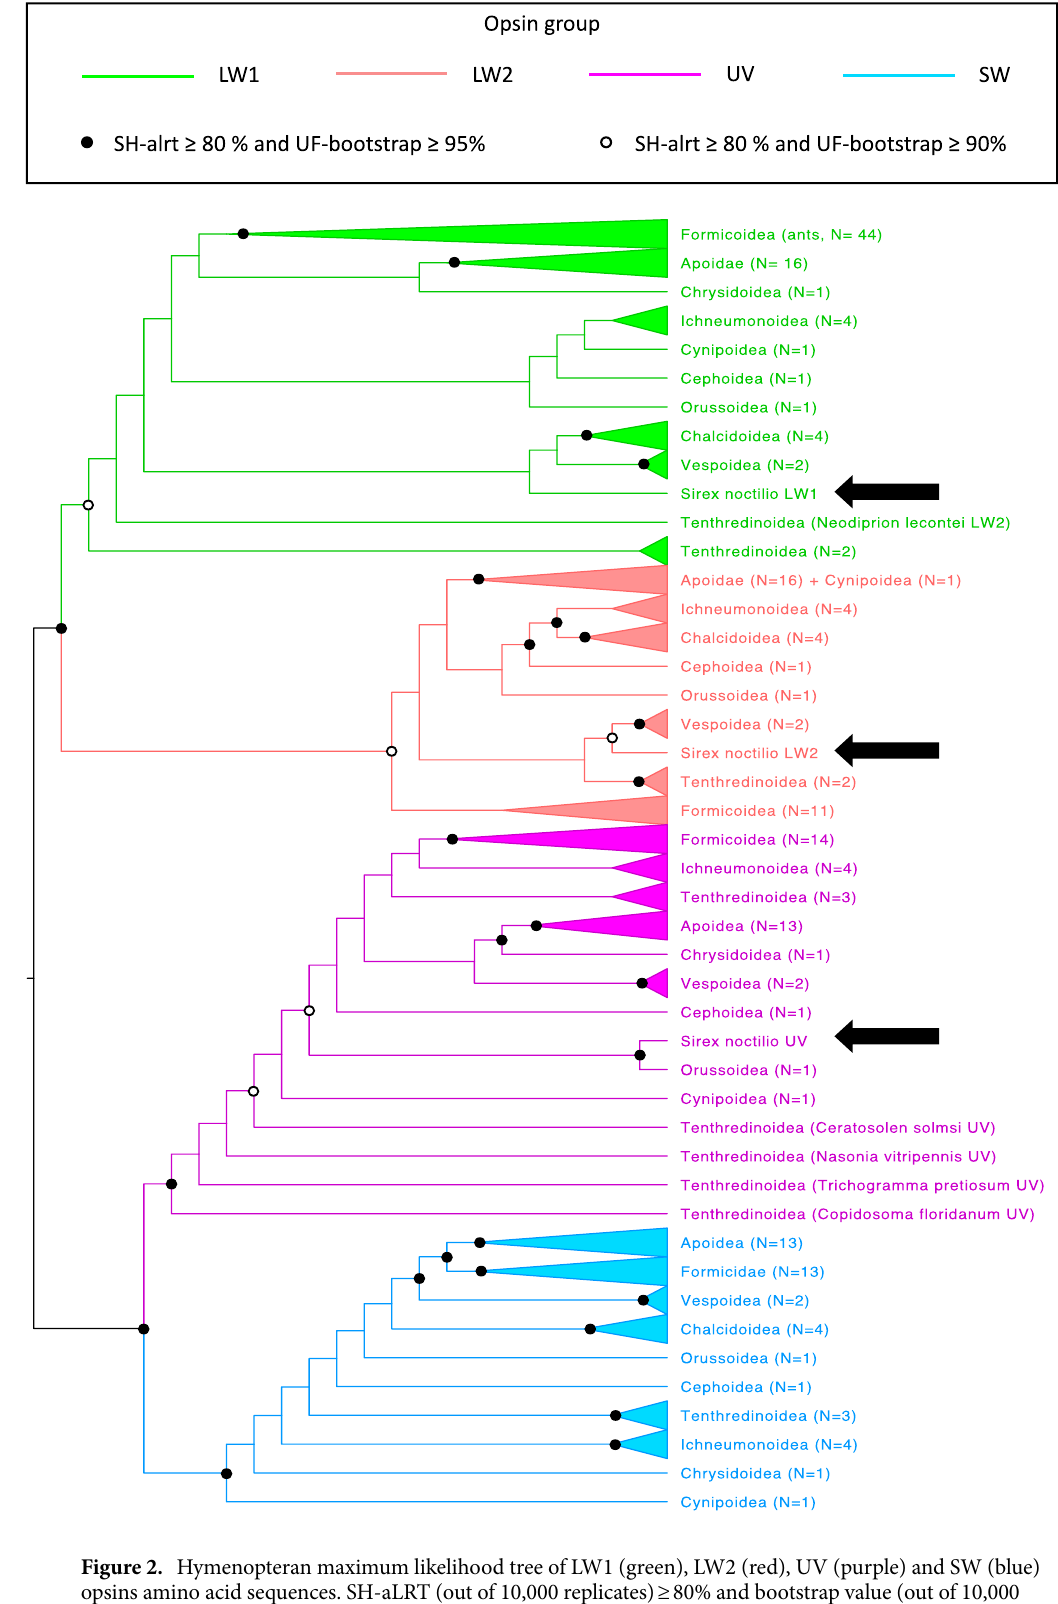
Figure 2. Hymenopteran maximum likelihood tree of LW1 (green), LW2 (red), UV (purple) and SW (blue) opsins amino acid sequences. SH-aLRT (out of 10,000 replicates) ≥ 80% and bootstrap value (out of 10,000 replicates) ≥ 90% (open circle) or ≥ 95% (black filled circle) are shown. Position of the visual opsin genes found in S. noctilio were indicated with a black arrow. Accession numbers and curated sequences are available (Table